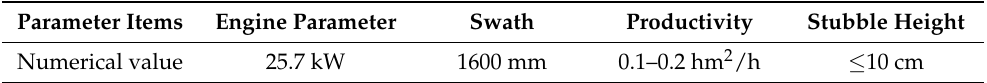
Figure 2. Model 4LMZ-160A ramie combine harvester. 1. Chassis and crawler track unit 2. Cab 3. Drag-link conveyer. 4. Reciprocating knife cutter 5. Lower divider and grain lifter 6. Upper pick-up reel. The main technical parameters of this ramie harvester are shown in Table 1. Table 1. Main technical parameters of this ramie harvester.